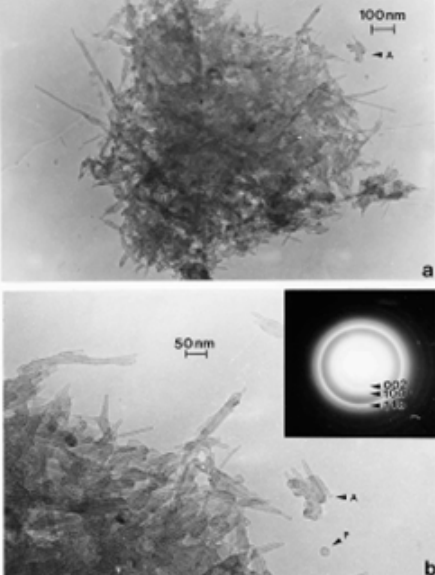
Figure 8: (a) Typical aggregate of carbon nanotubes and other fullerene polyhedra collected above a kitchen propane gas stove burner. (b) Magnified view of the aggregate in (a) showing a cluster of carbon (concentric) nanoshell structures (A) and a concentric, faceted, polyhedron (p). The SAED pattern insert show the principal graphite (graphene) reflections. The (002) diffraction ring corresponds to graphene (d) spacings of 0.34 nm. The propensity of carbon nanotubes of various length-to-diameter ratios (aspect ratios) relative to fullerene nanopolyhedra is roughly 9-to-1.